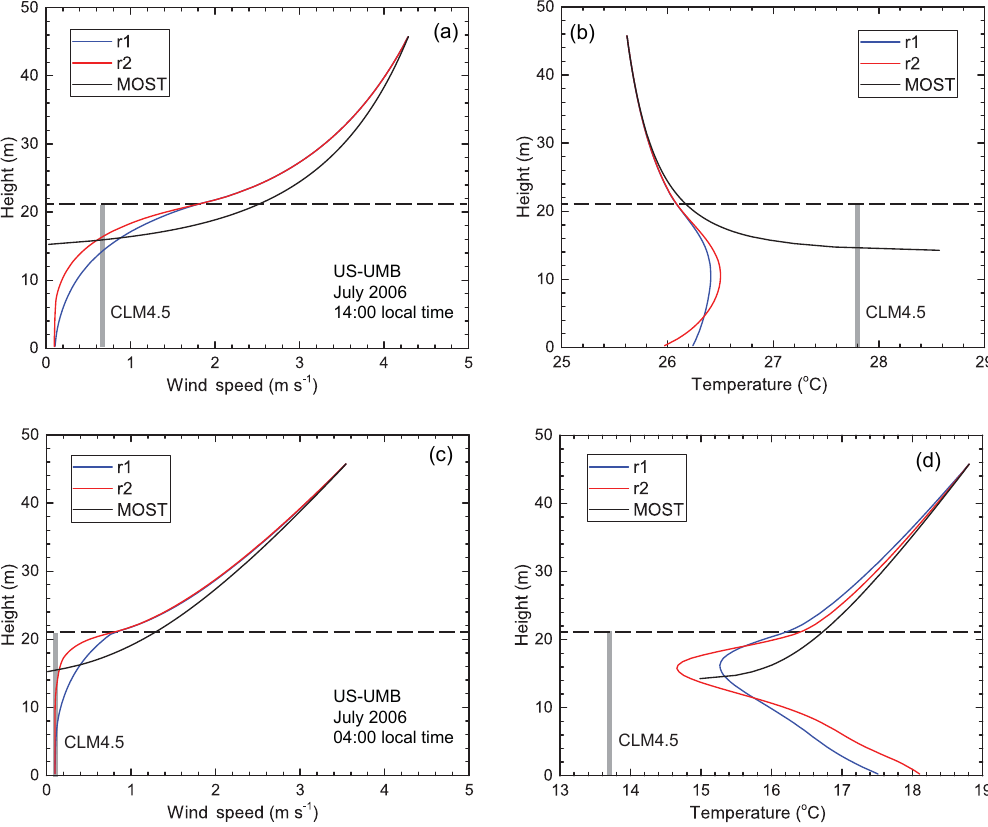
Figure 12. Profiles of wind speed and air temperature for US-UMB (July 2006) at 14:00 local time (a, b) and 04:00 local time (c, d) . Shown are the r1 and r2 simulations averaged for the month. The dashed line denotes the canopy height. The CLM4.5 canopy wind speed and air temperature are shown as a thick gray line, but are not vertically resolved. Also shown are the profiles obtained using MOST extrapolated to the surface. This extrapolation is for the r2 simulation using MOST flux–profile relationships and with roughness length and displacement height specified as in